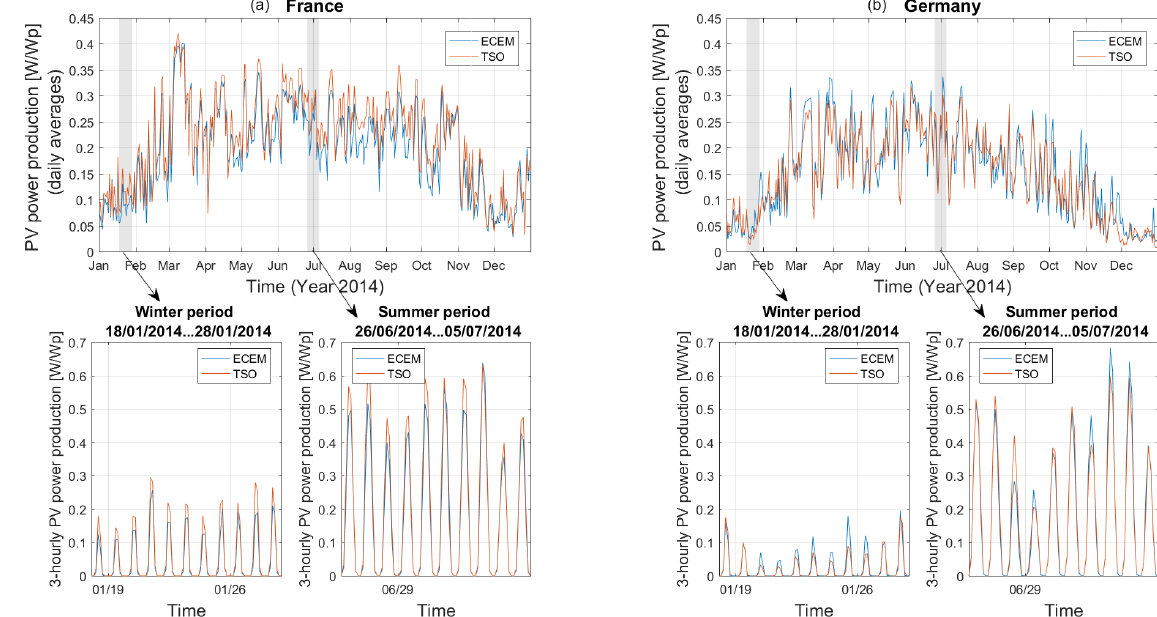
Figure 6. Comparison of the model output (blue lines) with TSO estimates (red lines) of the PV power generated in France (a) and Ger- many (b) . The data are displayed over the year with a daily time resolution in the two plots above and for two example weeks in a 3-hourly time resolution in the two lower plots.